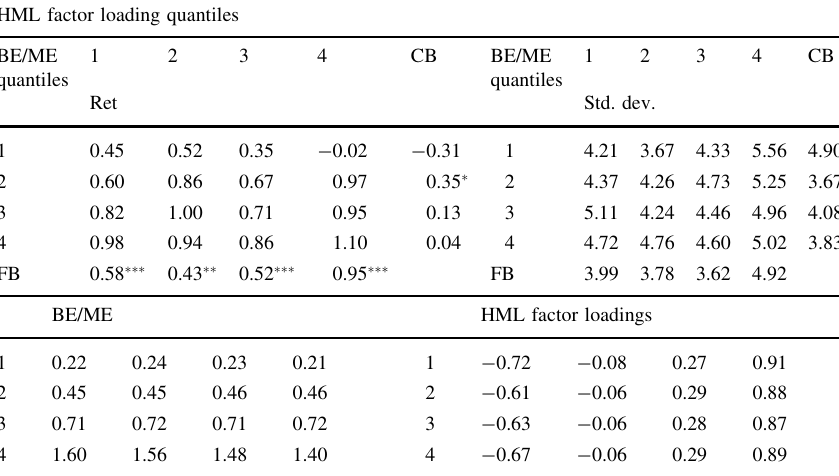
Table 10 Average monthly returns for portfolios formed from sorts on BE/ME and HML slopes HML factor loading